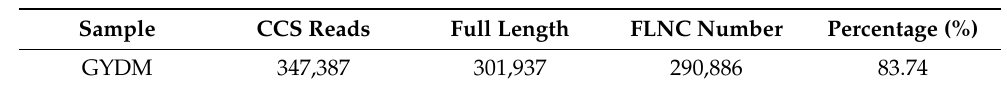
Table 1. Statistic of CCS reads